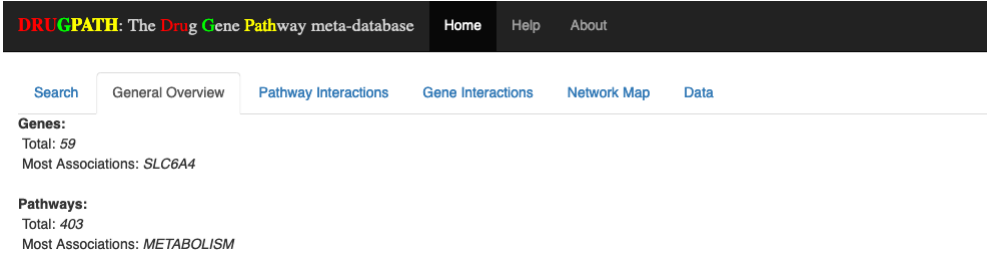
Figure 13. Quick overview of the total number of genes and pathways found, as well as the gene and pathway that had the most